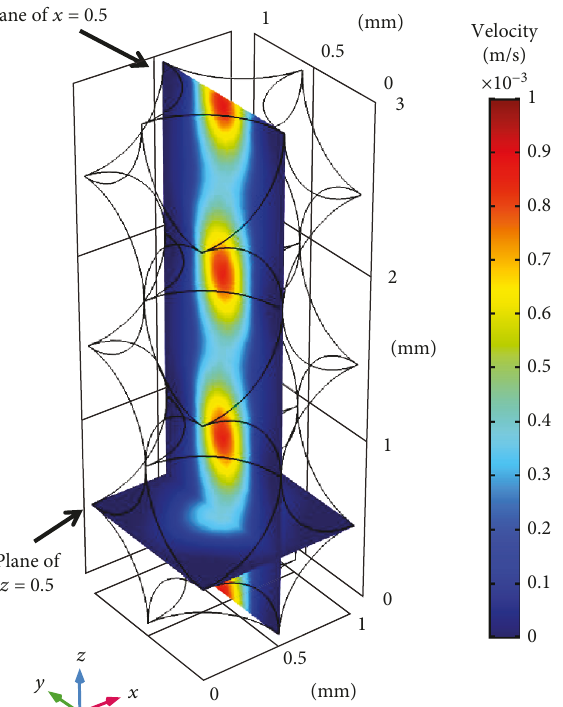
Figure 9: The magnitude of velocity on planes of x = 0 5 mm and z = 0 5 mm solved by